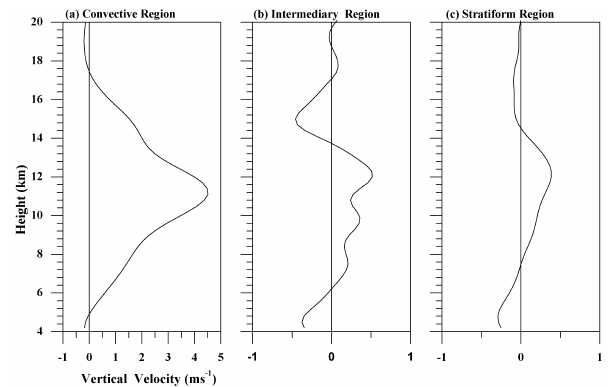
Fig. 13. Composite height profiles of clear air vertical velocities in (a) convective, (b) intermediary and (c) stratiform